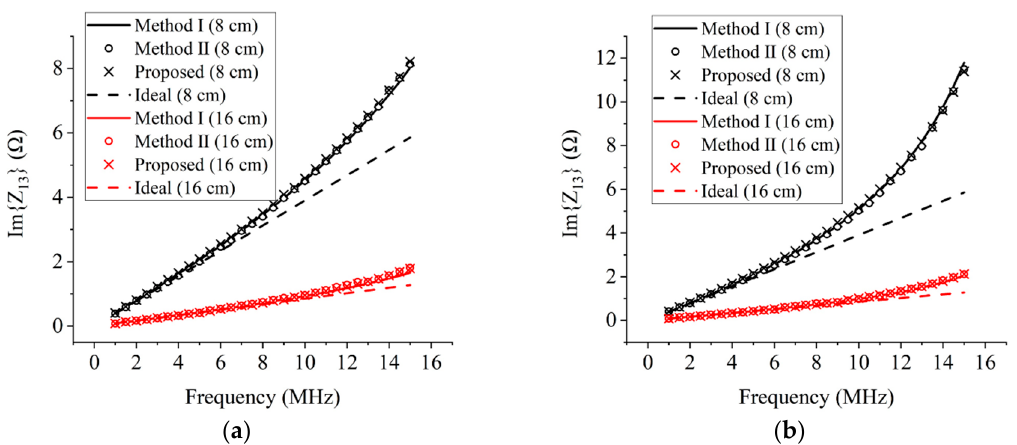
Figure 8. Measured transfer impedance Z 13 as a function of frequency for the farthest distance of 8 cm and 16 cm using the conventional and proposed methods: ( a ) Case #1 and ( b ) Case #2.